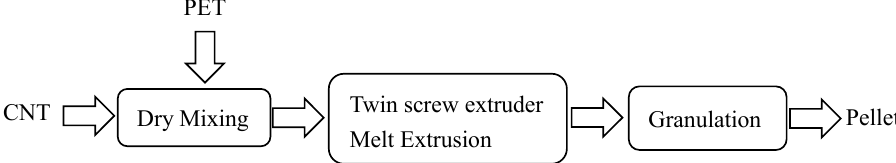
Table 1. CNT/PET mass ratio of composite samples.